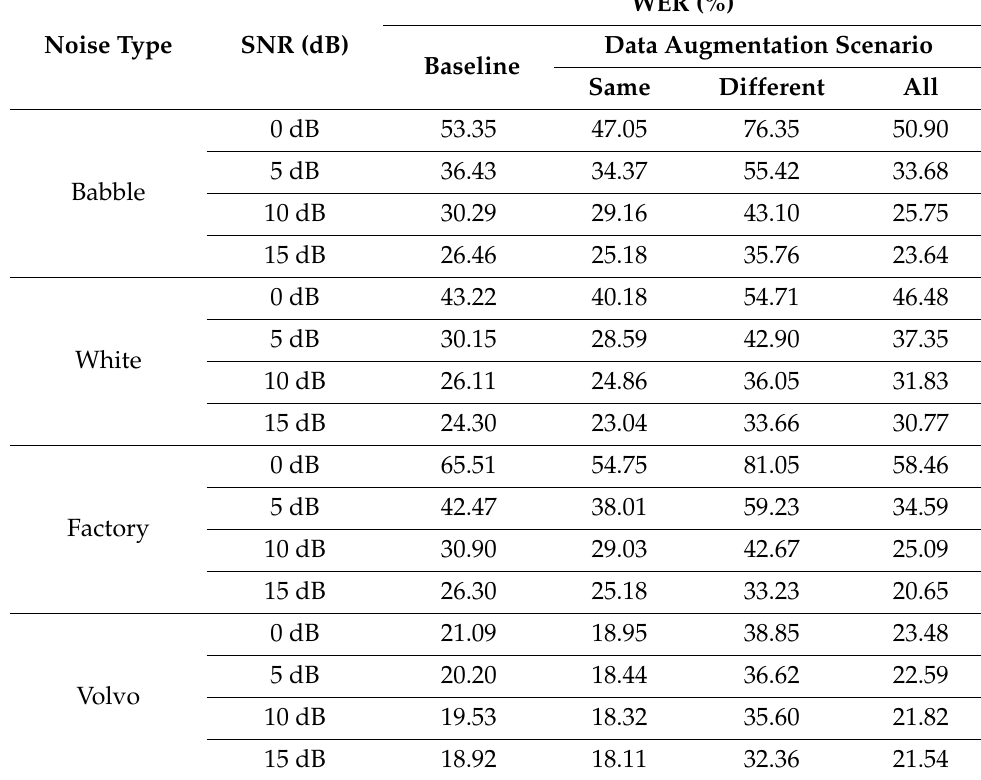
Table 3. WERs obtained using data augmentation in recognizing noisy children’s speech of four noise types in four SNR categories. Results obtained with the baseline system, which was trained without data augmentation using solely the noise-corrupted speech of the corresponding condition, are shown in the third column. WERs obtained using the three data augmentation scenarios described in Section 2 are shown in the fourth, fifth, and sixth